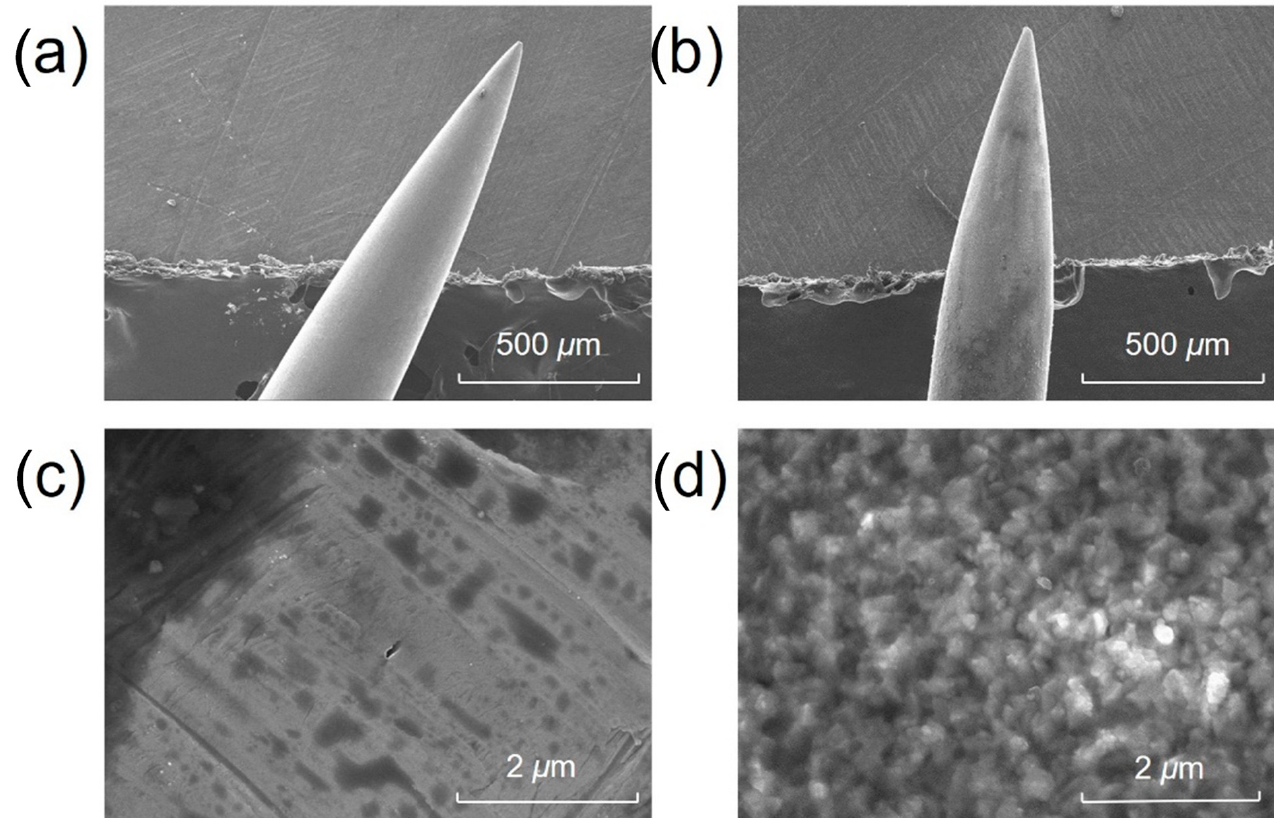
Figure 2. Scanning electron microscope (SEM) images of the acupuncture needle tip ( a , c ) prior to and ( b , d ) after surface oxidation.